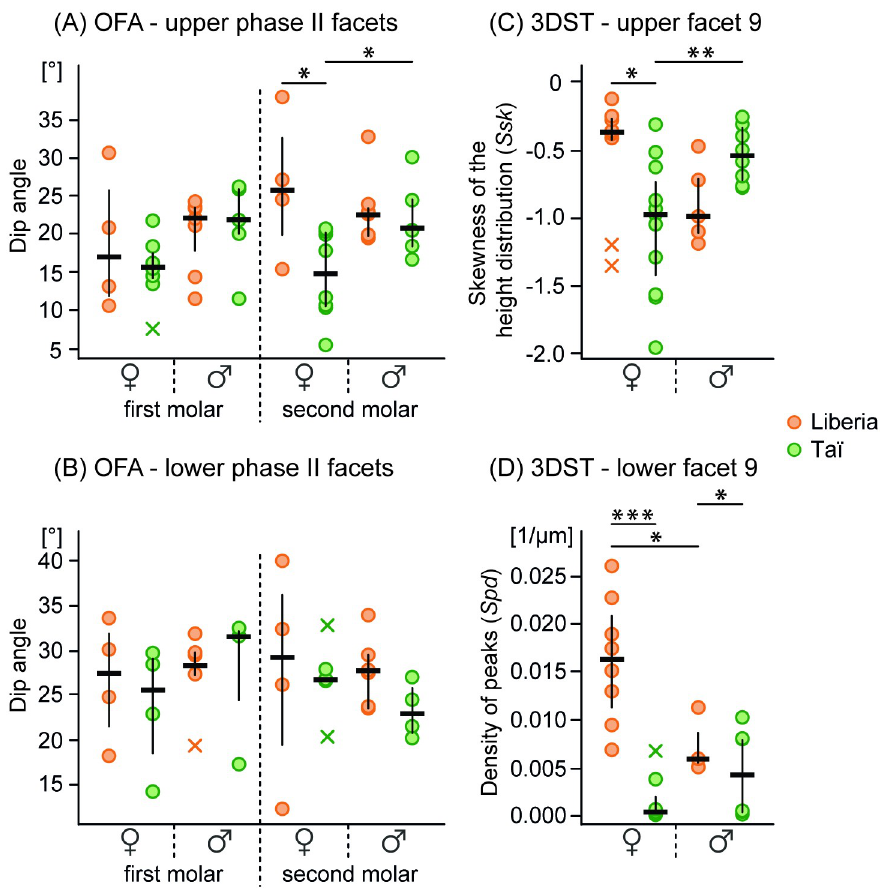
Fig 4. Variation between sexes and populations shown for phase II dip angles and selected 3DST parameters. Dip angle calculation on (A) upper and (B) lower phase II wear facets; (C) skewness of the height distribution ( Ssk ) on the upper facet 9; (D) density of peaks ( Spd ) on the lower facet 9. Strip charts indicate data median = horizontal line, interquartile range (IQR) = vertical line, and outlier ( > 1.5 � IQR) = x, significance levels are indicated by asterisks ( � � 0.05, �� < 0.01, ��� <